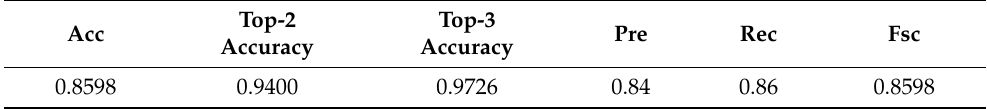
Table 3. Best accuracy using CNN learning model.